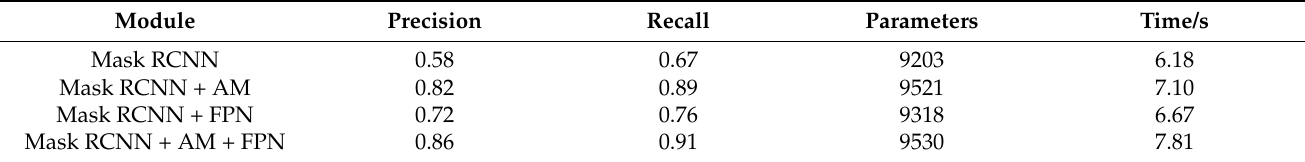
Table 2. Validation metrics of different models.